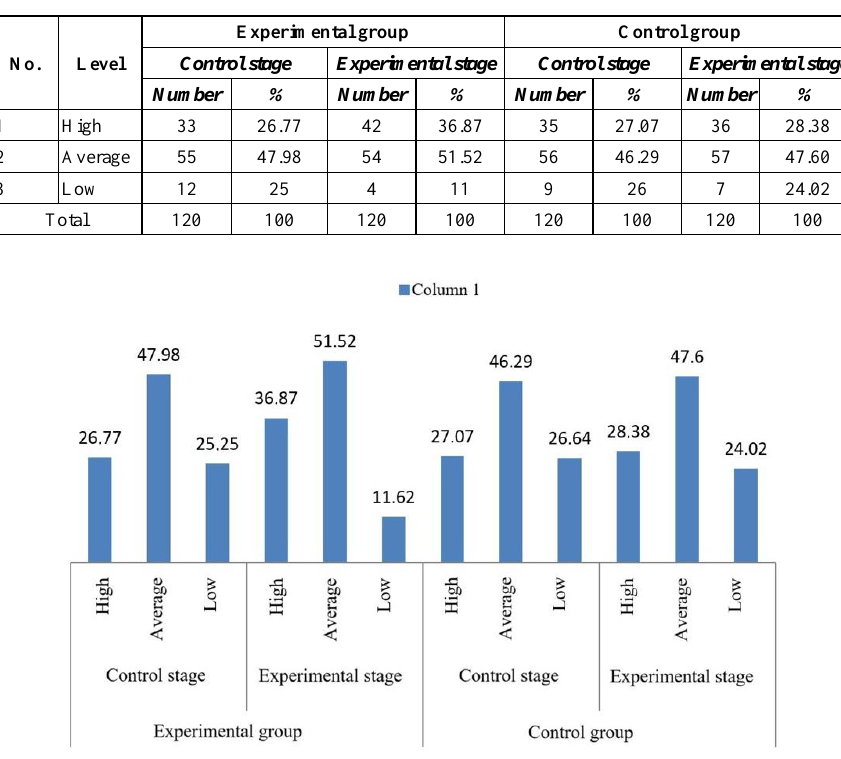
phases of the experiment, %